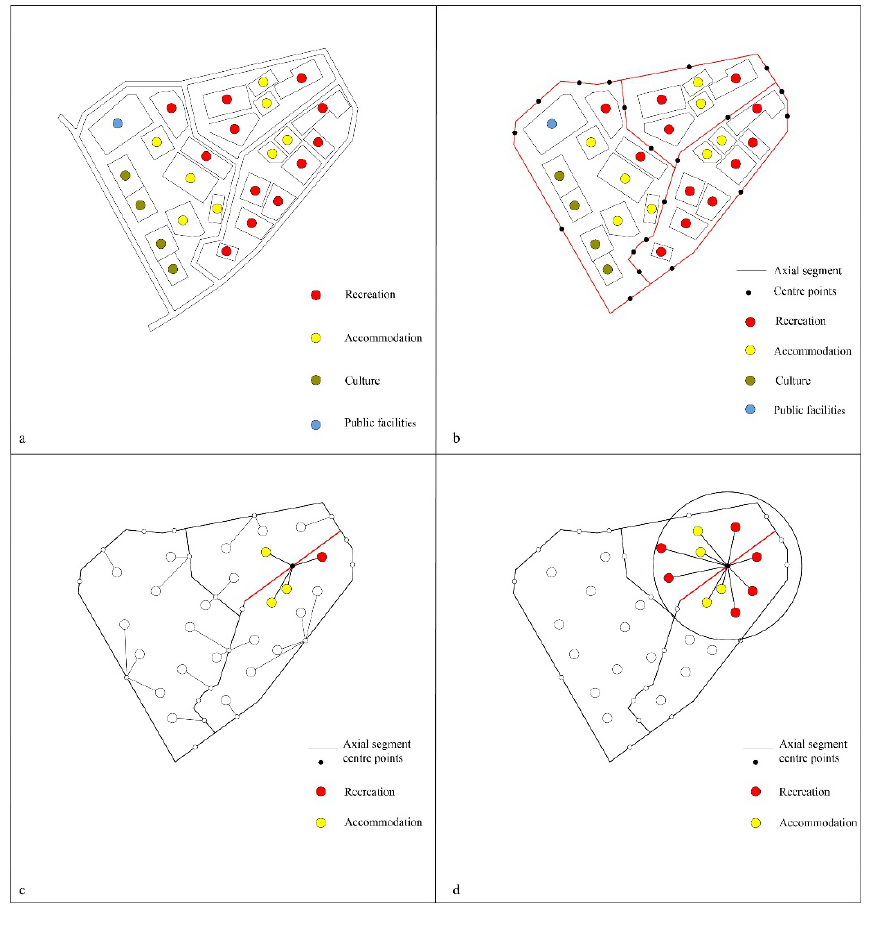
Figure 5. ( a ) Colour coding POIs; ( b ) generating axial segments; ( c ) creating the edges between axial segments and POIs; ( d ) illustrating the attractiveness of an axial segment to POIs within a given radius.